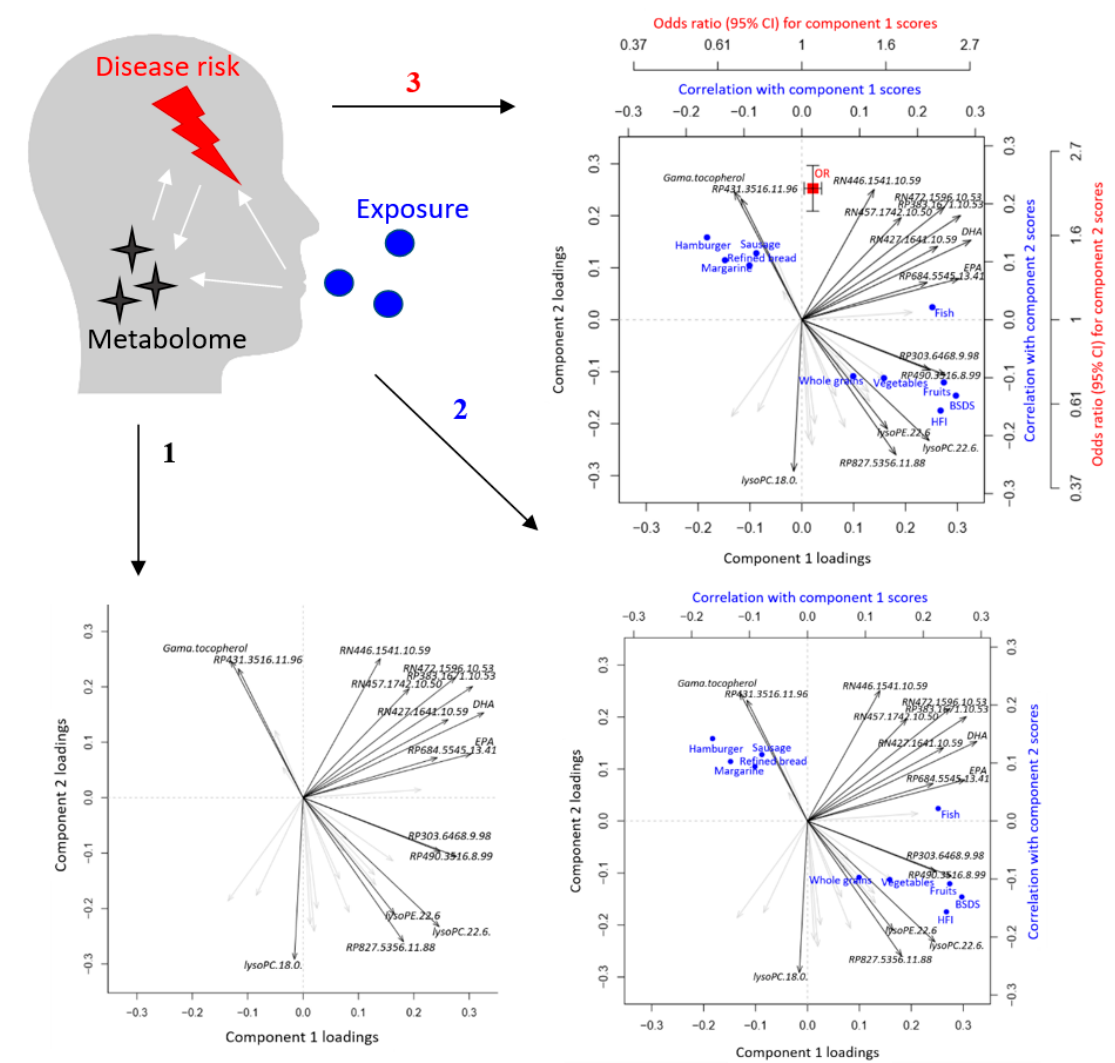
Figure 2. Link between exposures, metabolome, and disease risk as presented in the triplot. The first step consists of latent variable modeling of metabolomics data providing scores and loadings. The second step superimposes correlations between component scores and exposures (or covariates). The third step superimposes risk of outcome associated with the component scores.